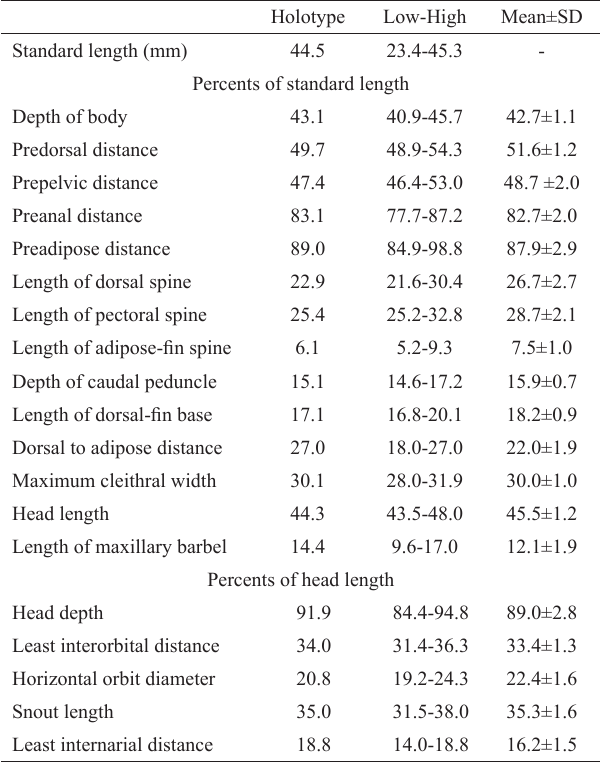
Table 1. Morphometric data of holotype and 19 paratypes of Corydoras eversi. SD = standard